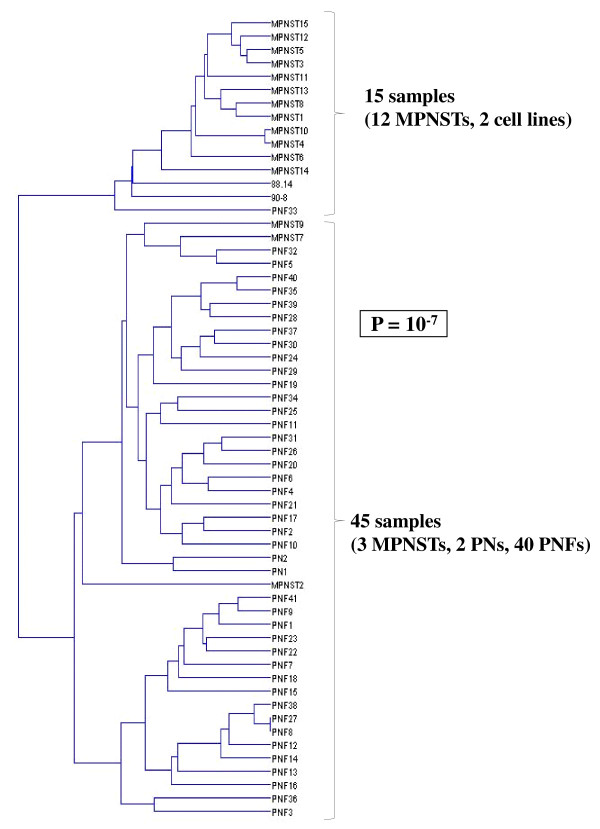
Dendrogram of the 41 PNFs, 15 MPNSTs, two peripheral nerves and two MPNST cell lines constructed using a supervised hierarchical clustering with UPGMA algorithm according to the expression of the 28 miRNAs most significantly deregulated between PNFs and MPNSTs.